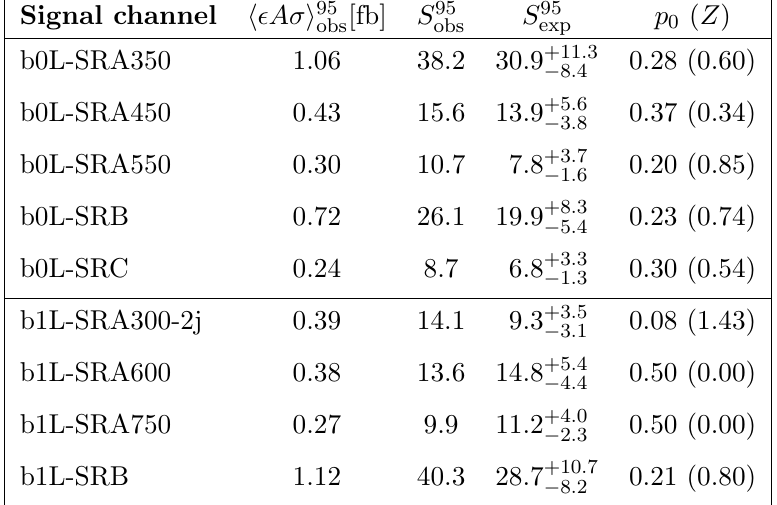
Table 10. Left to right: 95% CL upper limits on the visible cross-section ( h (cid:15)A(cid:27) i 95 ) and on the obs number of signal events ( S 95 ). The third column ( S 95 ) shows the 95% CL upper limit on the exp obs number of signal events, given the expected number (and (cid:6) 1 (cid:27) variations of the expected number) of background events. The last column reports the p 0 -values and Z (the number of equivalent Gaussian standard deviations). The maximum allowed p 0 -value is truncated at